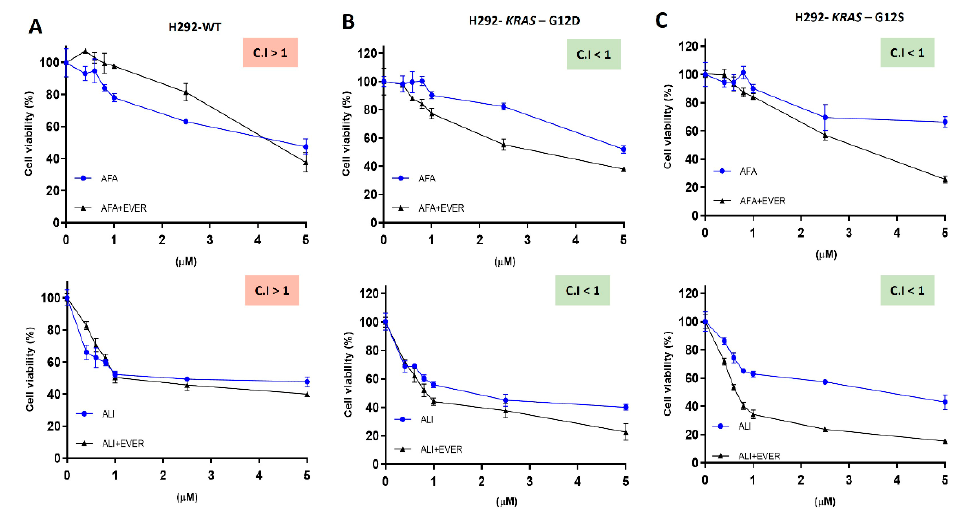
Figure 5. Cell viability assay of wild-type-WT ( A ) KRAS mutated cell G12D ( B ) and KRAS mutated cell G12S ( C ) exposed to EGFR inhibitors in combination with everolimus (1 µM) for 72 h. Squares represent combination index (CI) values. Synergy (CI < 1.0); antagonism (CI > 1.0); and additivity (CI = 1.0). AFA: afatinib, ALI: allitinib, EVER: everolimus. Data presented as the mean of three independent experiments.